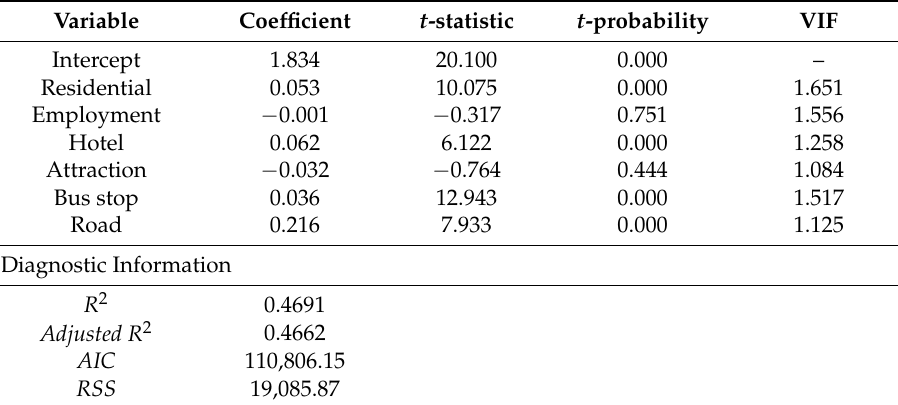
Figure 6. The parameter selection for the GTWR model. Table 3. Estimation result for the OLS model.